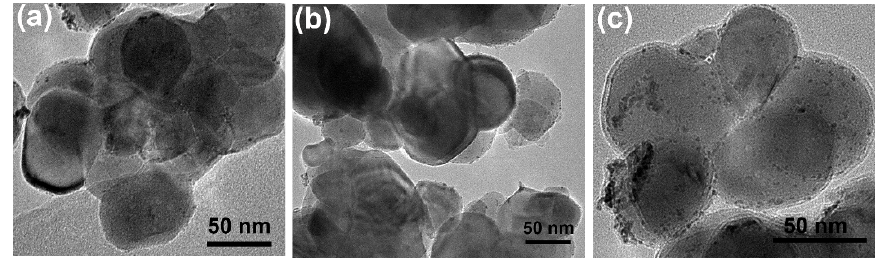
Figure 6. TEM images of three nanomaterials (( a ) Pd Cs-1/ZnO 1 − x , ( b ) Pd Cs-2/ZnO 1 − x , and ( c ) Pd Cs-3/ZnO 1 − x , respectively).